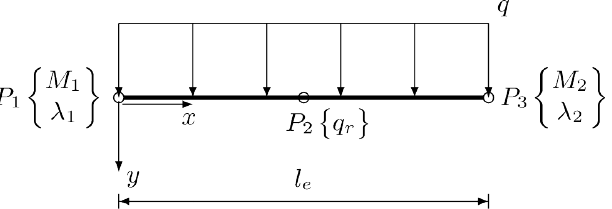
Figure 2. Three-node, five-degrees-of-freedom stress-based beam